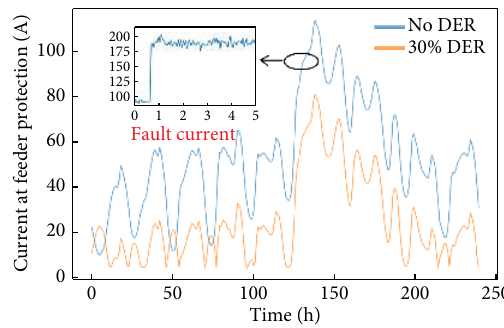
Fig. 5 Feeder source current at different